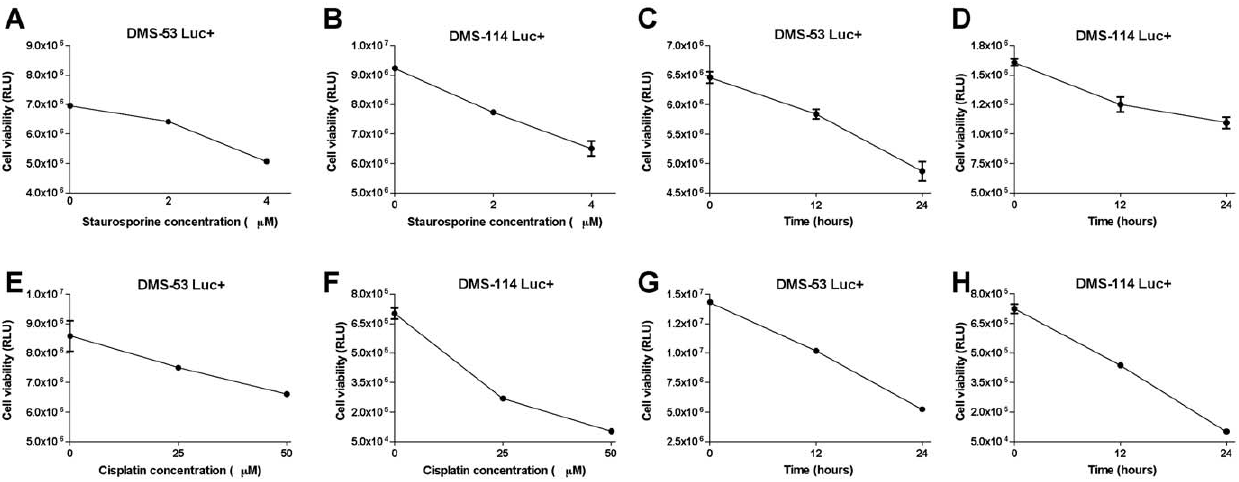
Figure 2. Bioluminescent SCLC cell lines respond to pharmacological agents in a dose- and time-dependent manner. DMS-53 luc + and DMS-114 luc + cells were treated with 0, 2, and 4 m M staurosporine, an apoptotic drug, for 24 hours ( A,B ) or with 4 m M staurosporine for 0, 12, and 24 hours ( C,D ). DMS-53 luc + and DMS-114 luc + cells were treated with 0, 25, and 50 m M cisplatin, a chemotherapeutic drug, for 24 hours ( E,F ) and 50 m M cisplatin for 0, 12, and 24 hours ( G,H ). Luciferase assays were then performed to measure cell viability. Data points represent mean values and error bars represent standard error of means (n=5). RLU – relative luminescence units.